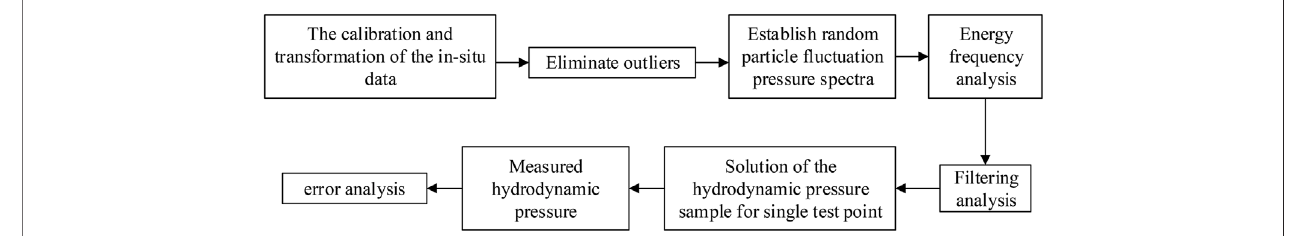
FIGURE 5 | Data acquisition and processing fl ow of fi eld test system.